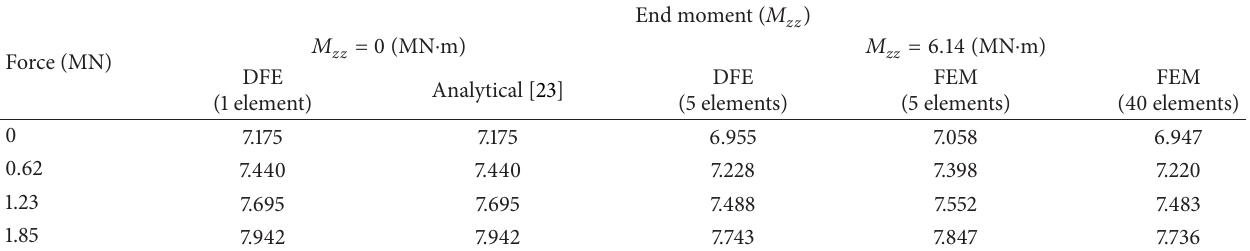
Table 3: DFE fundamental frequencies (Hz) for pinned-pinned (P-P) boundary condition.